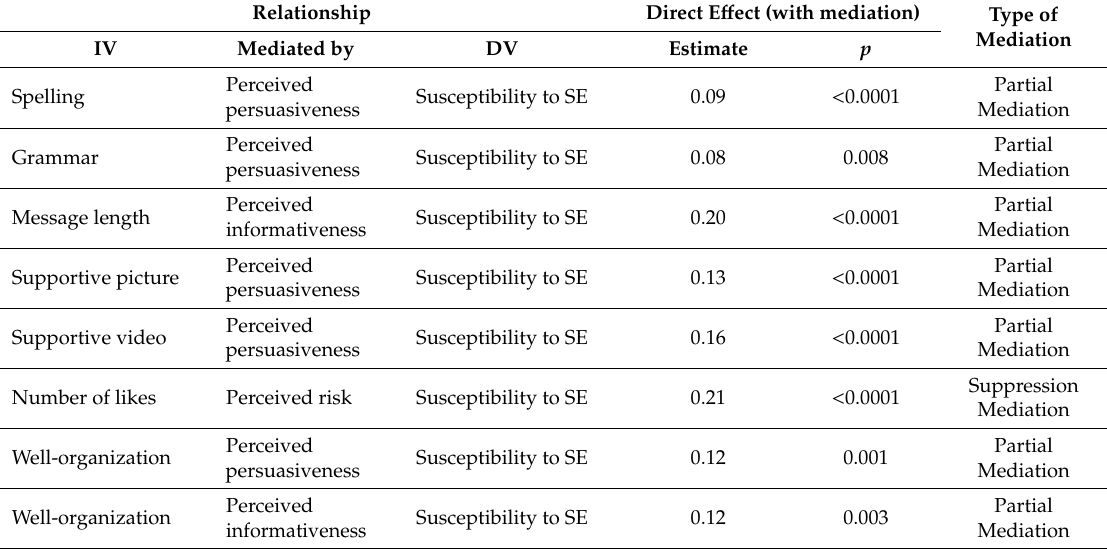
Table 9. Mediation e ff